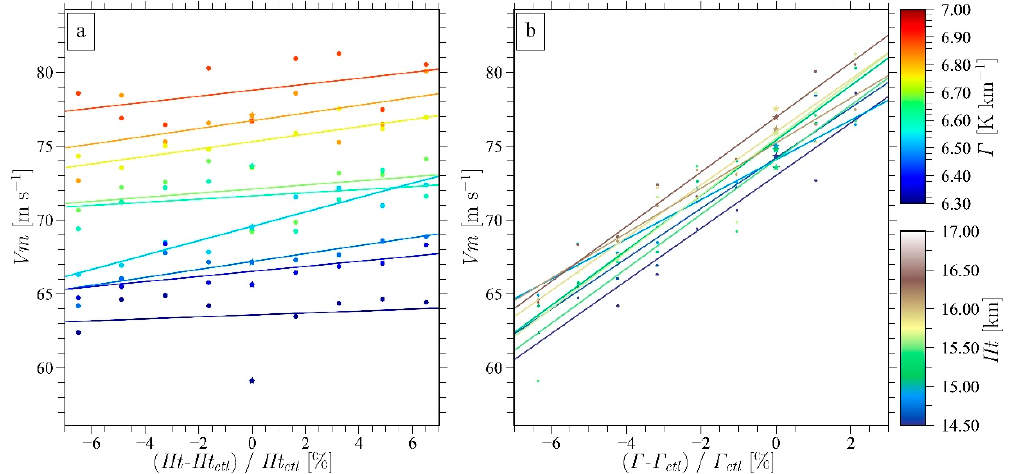
Figure 4. Relationships between the maximum wind speed of the simulated TCs and the stability. Stability is indicated by ( a ) tropopause height or ( b ) tropospheric temperature lapse rate. Each dot indicates the result from each numerical experiment. Each line shows a linear-fitted line from the results of the cases ( a ) when the temperature lapse rate is fixed to a specific value (color legend on the right) and when the tropopause height is fixed to a specific value (color legend on the right). The values of the horizontal axis are normalized by the control values.